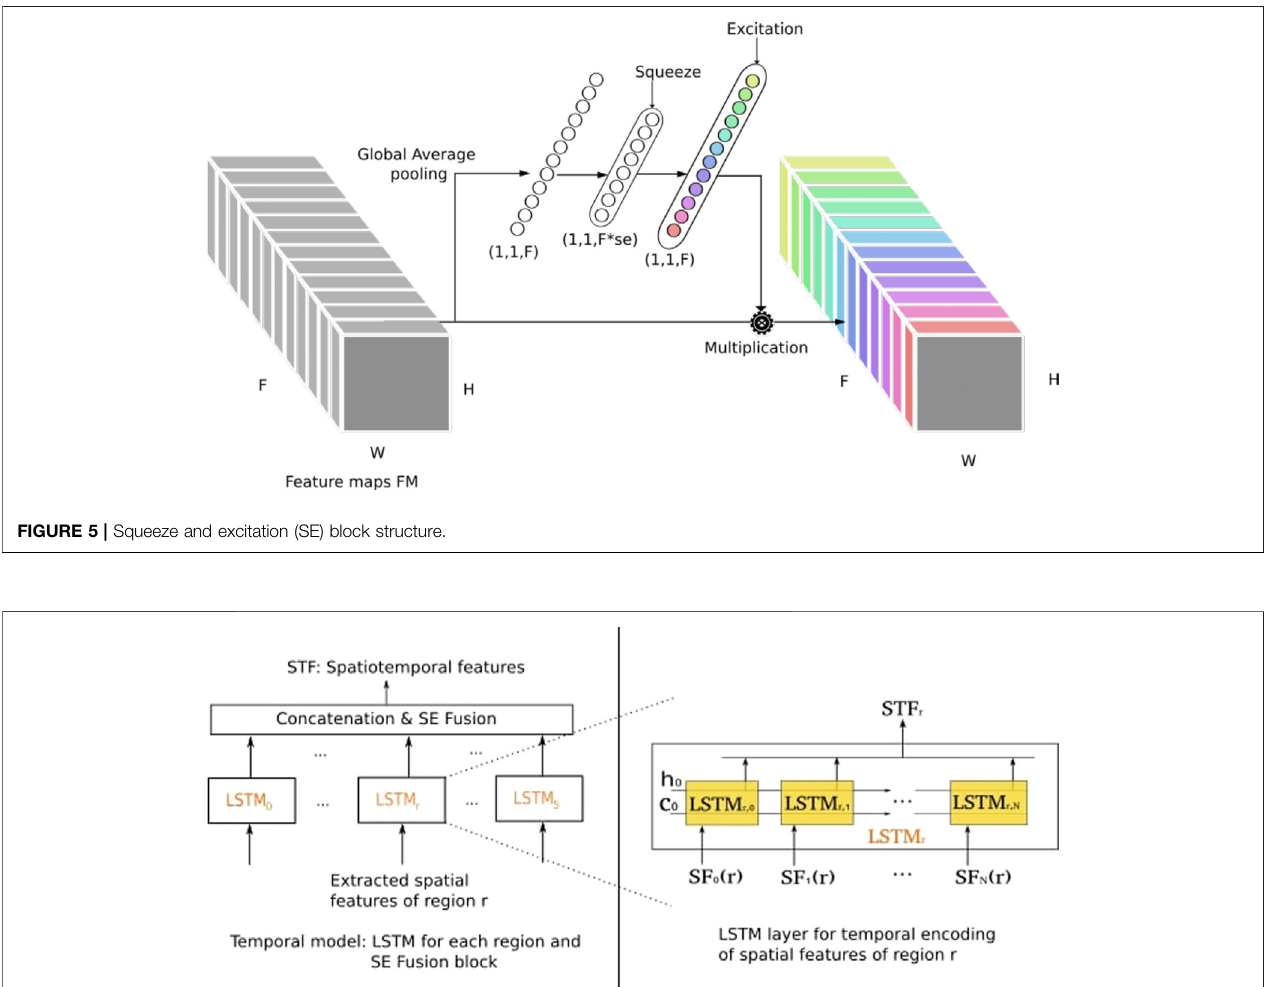
Frontiers in Signal Processing |